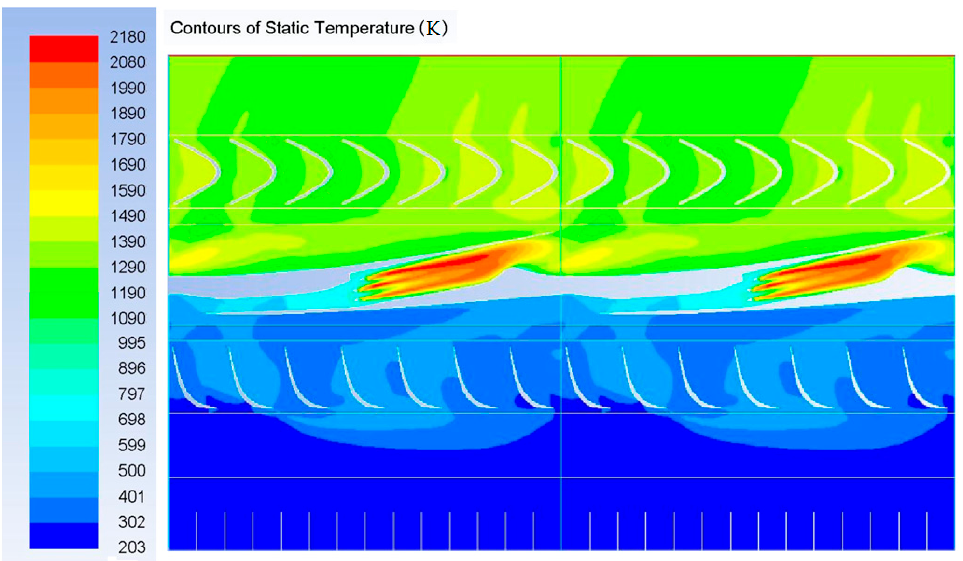
Figure 26. Pressure distribution on the walls of the engine channels.